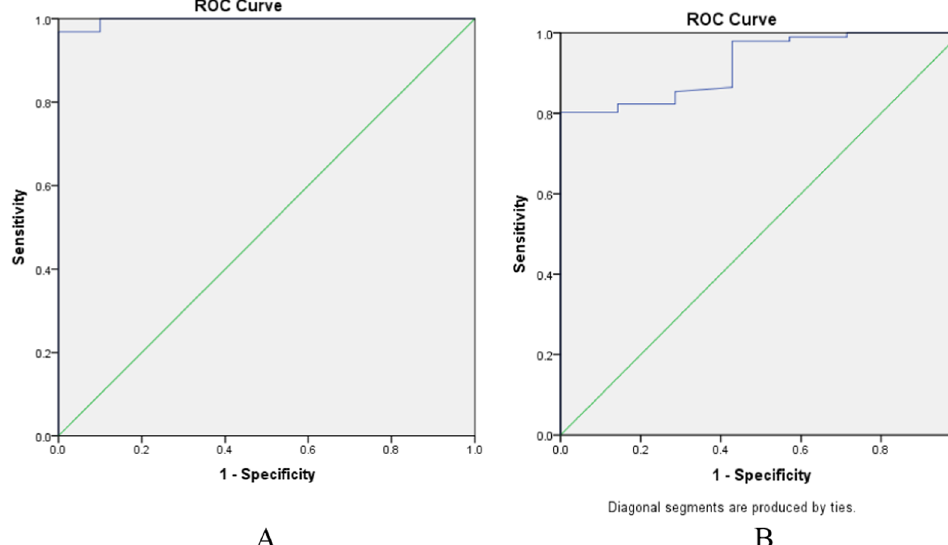
Fig. 1 ROC Curve analysis of A P53 gene expression B ARF gene expression for diagnosis of AML patients